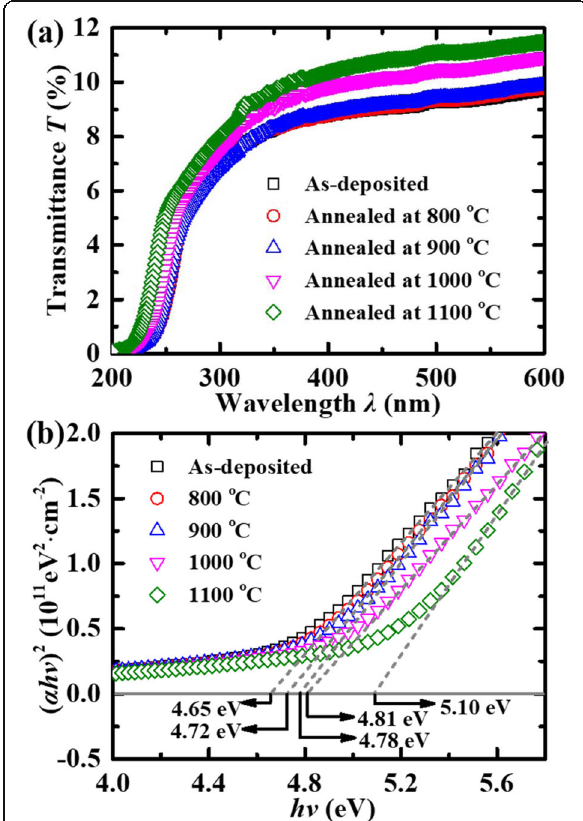
Fig. 5 a Transmittance spectra of as-deposited and annealed poly- (Al